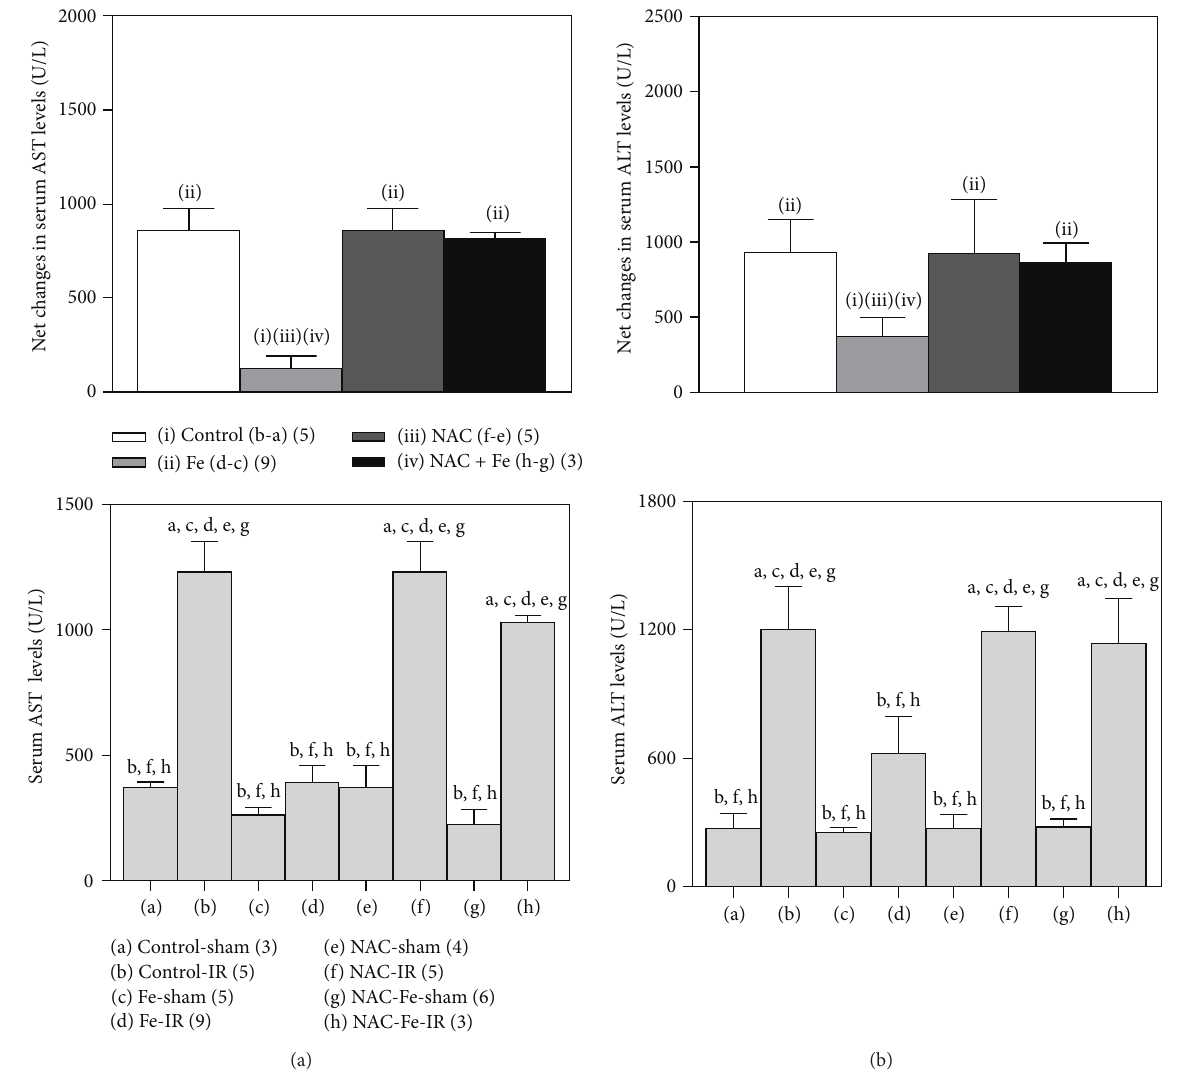
Figure 2: Effects of N-acetylcysteine (NAC) and/or iron (Fe) short-term administration on serum aspartate transaminase (AST) (a) and alanine transaminase (ALT) (b) levels in rats subjected to ischemia-reperfusion (IR). Animals were treated as shown in Figure 1. Data are expressed as means ± SEM for 3 to 9 animals per group. Significance studies ( 𝑃 < 0.05 ; one-way ANOVA and Newman-Keuls’ test) are indicated by the letters identifying each experimental group. Inset: net changes in serum AST and ALT levels induced by IR correspond to the differences between groups (b-a) (controls), (d-c) (Fe), (f-e) (NAC), and (h-g) (NAC + Fe).